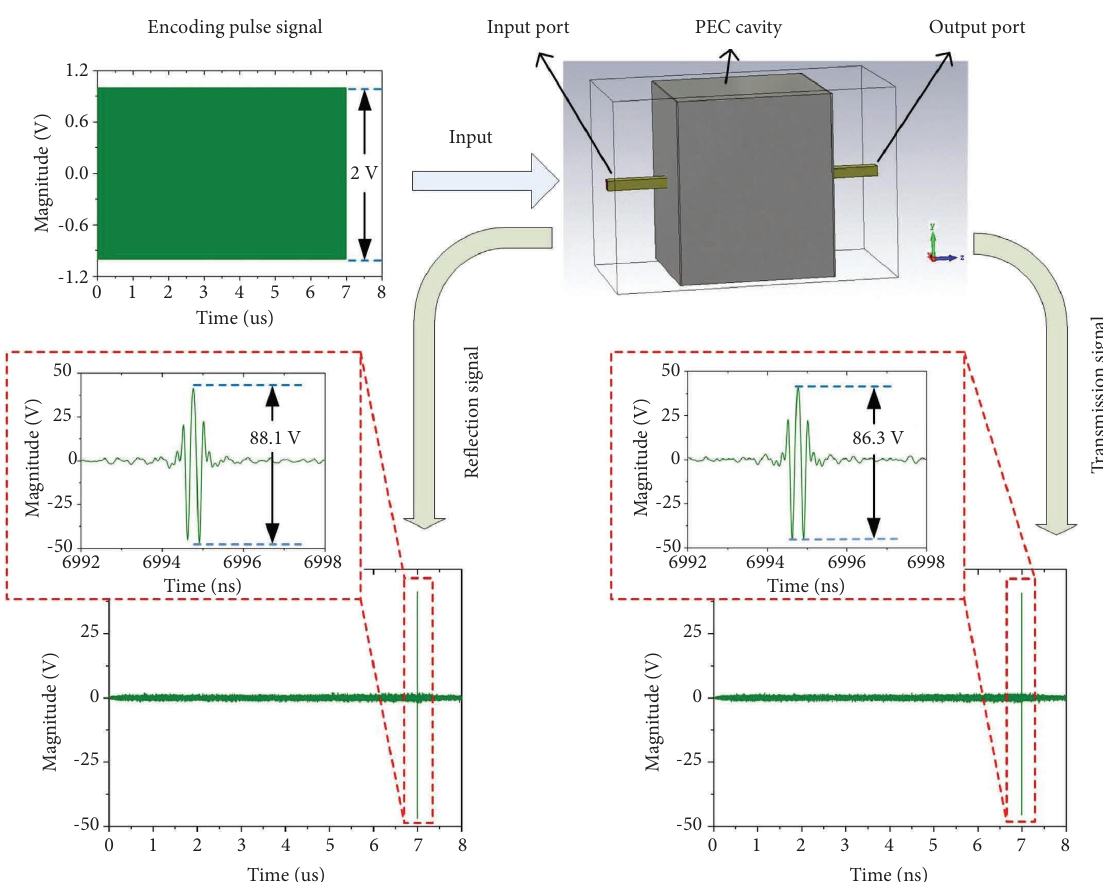
Figure 2: Te established simulation model with two BJ-32 ports for obtaining the USP signal by using the multipath scattering efect of a rectangular reverberation chamber (the size of the chamber is 1m × 1 m ×